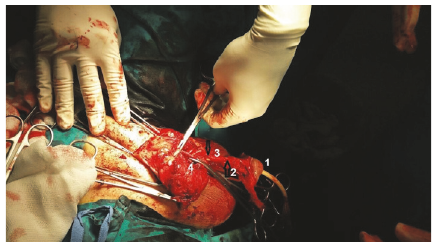
Figure 3: Intraoperative photo demonstrating normal, well- vascularised glans (1), corpus spongiosum (2), penile urethra (3), and clamped right cavernosal artery (4). There are two points on penile urethra which were debrided due to infection (arrows).